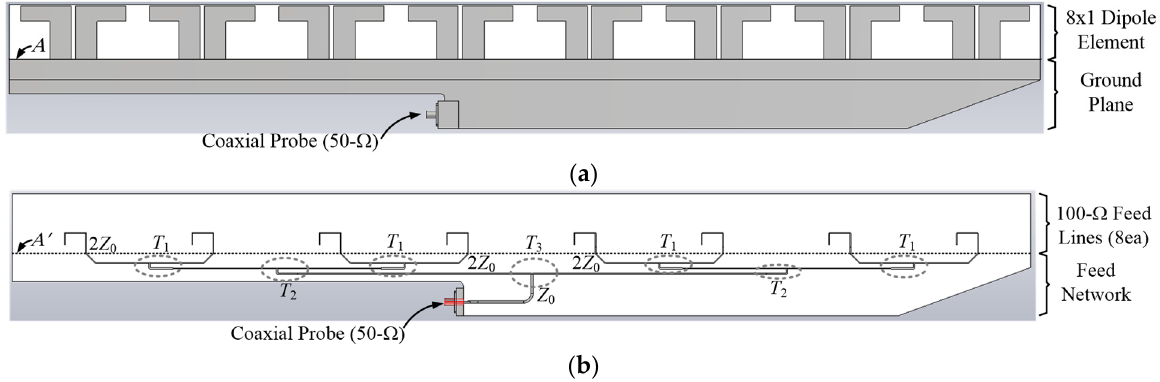
Figure 3. Geometry of the substrate printed by the 8 × 1 subarray: ( a ) top view and ( b ) bottom view.